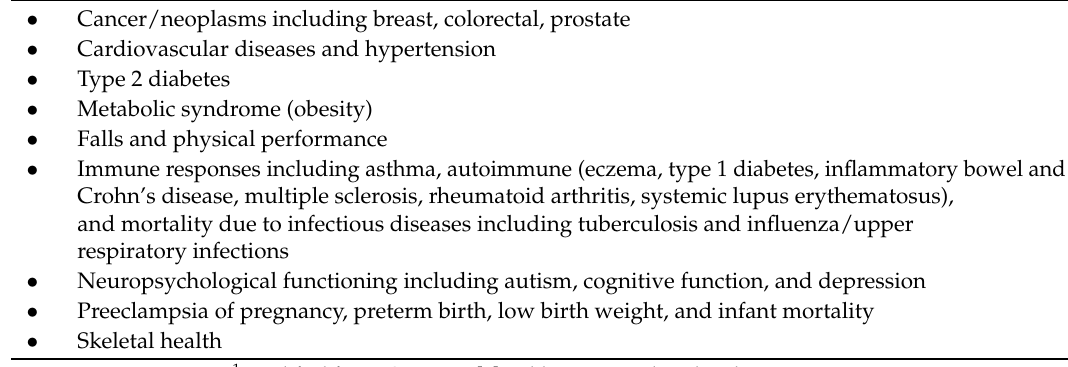
Table 1. Health/disease conditions suggested as linked to vitamin D 1